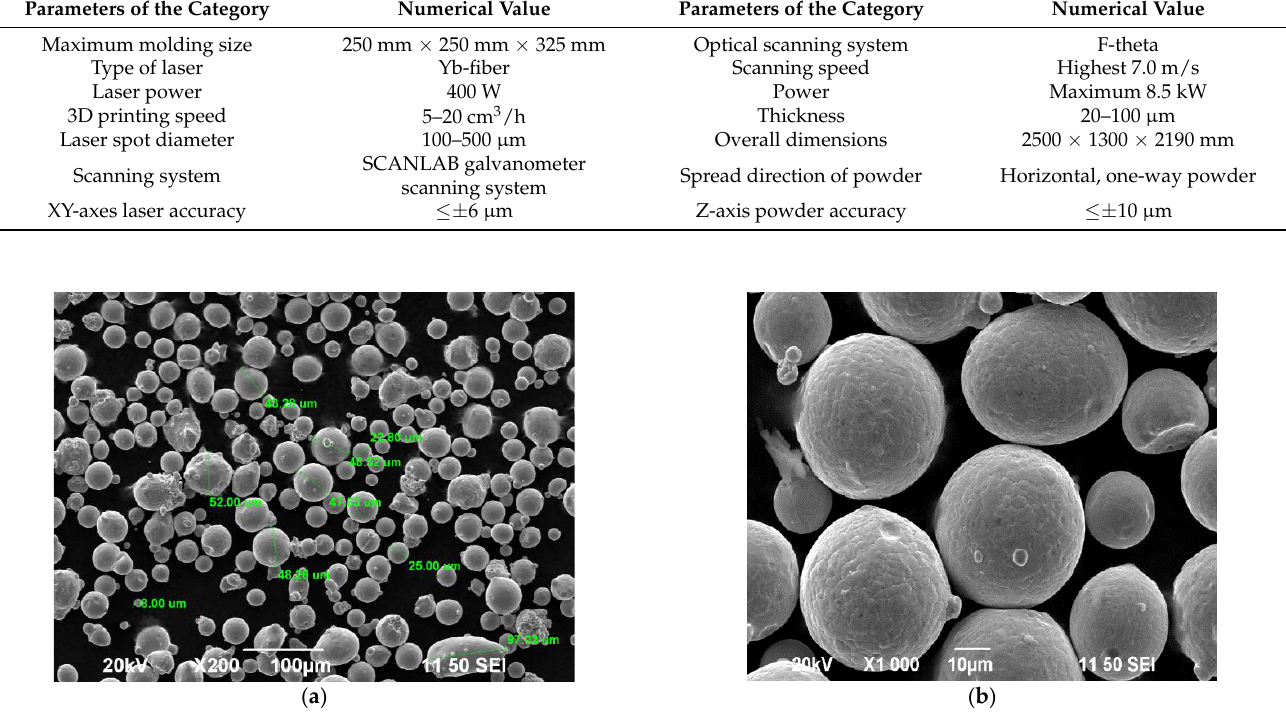
Figure 4. SEM morphology of EOS maraging steel MS1: ( a ) 100×, ( b ) 1000×. Table 2. Chemical composition and weight (wt.%) of EOS maraging steel MS1 [42].